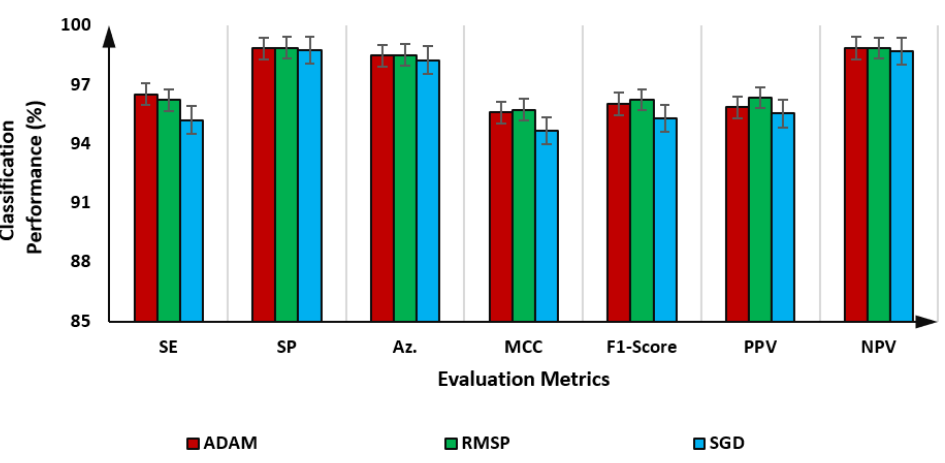
Figure 5. Evaluation classification results of the proposed BCNet as an average over 5-fold tests using ADAM, RMSP, and SGD optimizers.